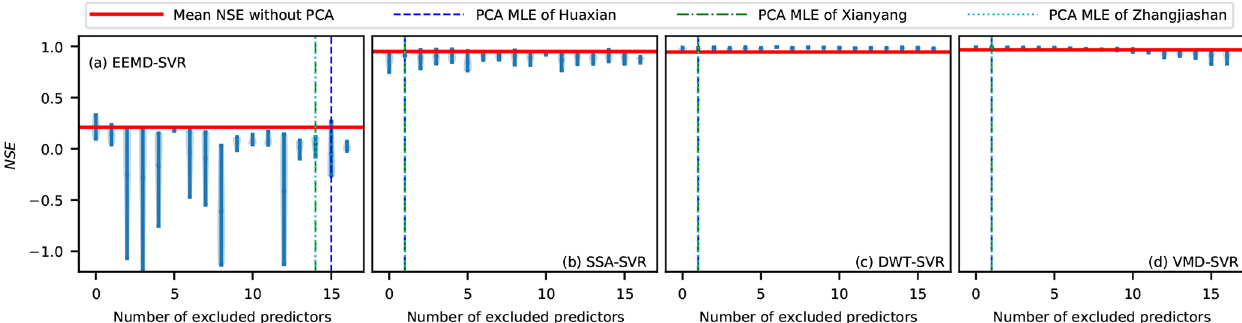
Figure 18. Violin plots of the NSE values for different numbers of excluded components and 1-month-ahead runoff forecasting.